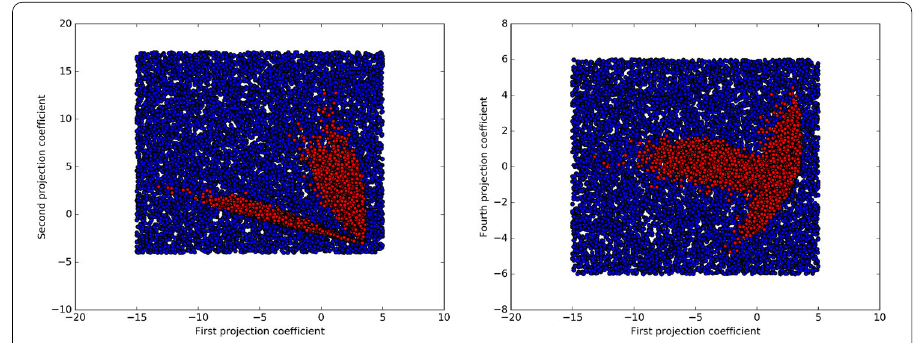
Fig. 5 Projection coefficients on the traffic emissions basis from LHS performed directly on [ α lin min , α lin max ] N lin (blue) compared to the projection coefficients of traffic emissions model outputs E ( p traffic , p e ) (red) over a training ensemble of parameters ( p i traffic , p i e ) selected by LHS. Left: the parameter space of ( α lin , α lin the parameter space of ( α lin 1 4